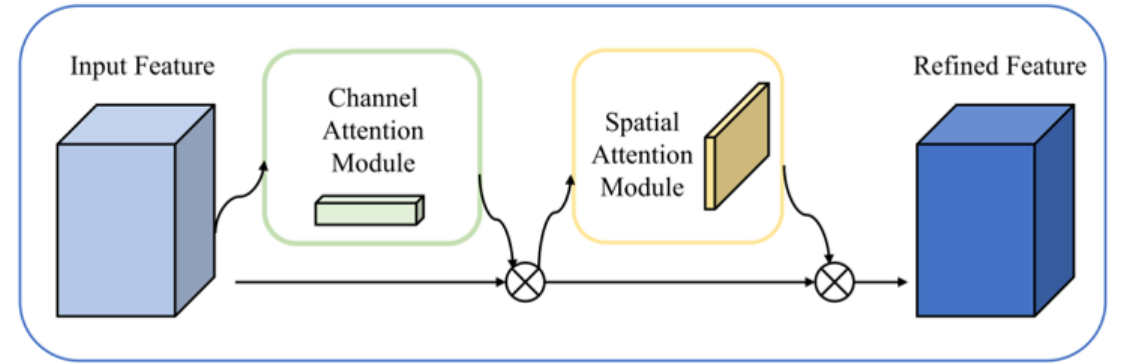
Figure 7. Convolutional block attention module (CBAM).